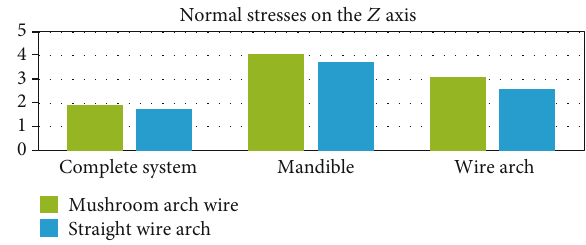
Figure 26: Normal stresses in the Z axis (MPa). The graph shows a comparison between the stresses in the Z axis that were generated in each of the analyzed sections: complete system (mandibular bone, dental organs, brackets, and wires) and separately the mandible and the two di ff erent types of arches or wires.